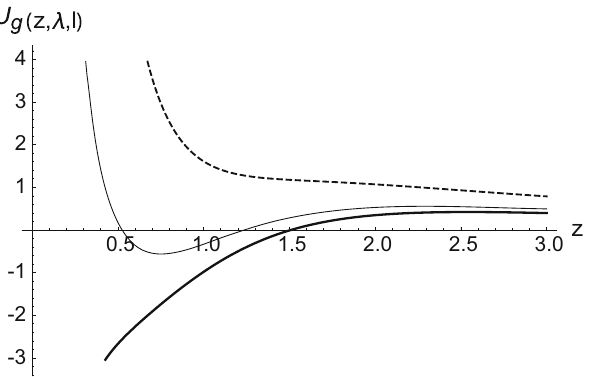
Fig. 11 Gravitational (and scalar field) Schrödinger potential in the warped disk model for λ = 0 . 3 and c = 0 . 6. Thick line l = 0, thin line l = 1 and dashed line l = 2